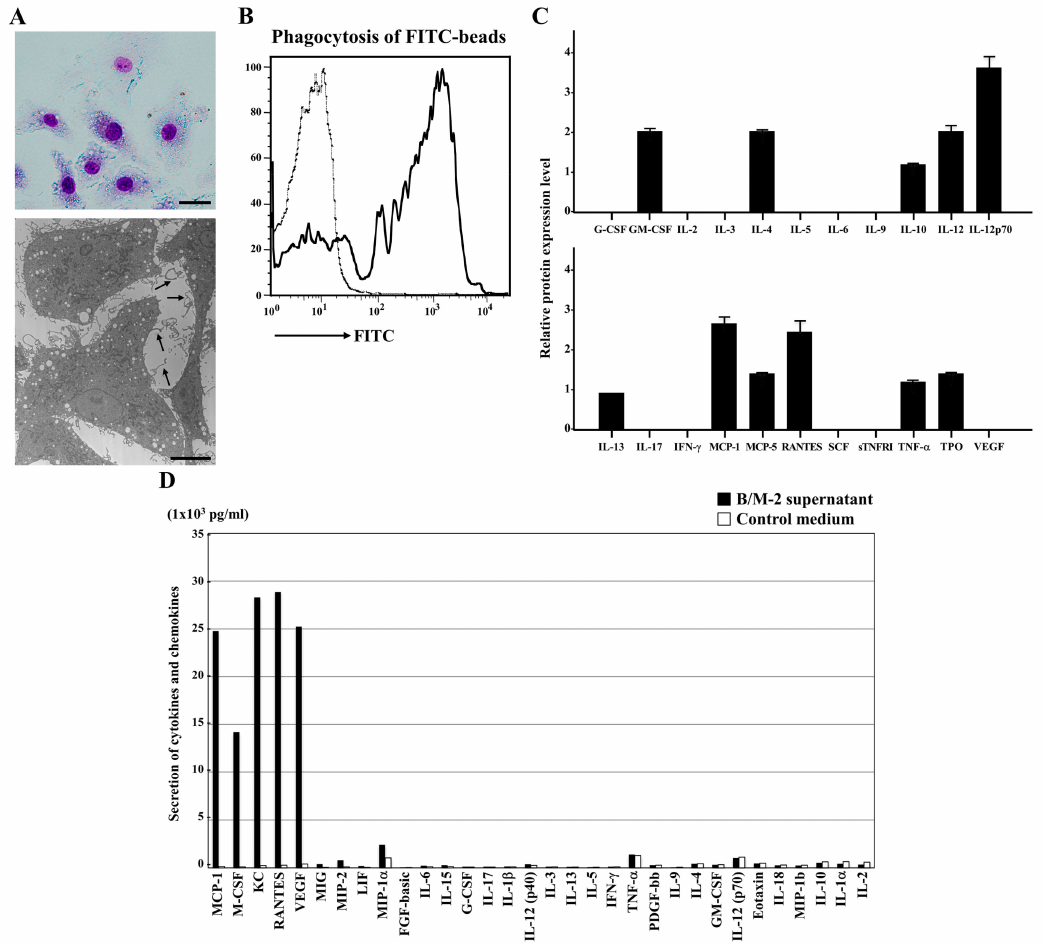
Figure 4. Morphological and functional properties of the Hodgkinoid cell line B / M-2 derived from Ig - ganp Tg mice. ( A ) A representative B / M-2 is morphologically analyzed by Wright–Giemsa staining (upper panel; scale bar = 20 µ m) and electron microscopy (lower panel; scale bar = 7 µ m). B / M-2 cells are larger in size, irregularly shaped, rich in vacuoles in the cytoplasm, and exhibit many fine cell processes on the surface (arrows). ( B ) The phagocytic activity in B / M-2 cells was determined by measuring the uptake of fluorescein isothiocyanate (FITC)–microspheres. Cells cultured in the absence of FITC–microspheres are used as negative control (thin line). ( C ) Measurement of cytokine expression in B / M-2 cells. Signal intensity is calculated using a densitometer, and the value of IL-13 is defined as 1.0 for relative comparison. ( D ) Cytokine / chemokine secretion from B / M-2 cells. A serum-free medium is used as a